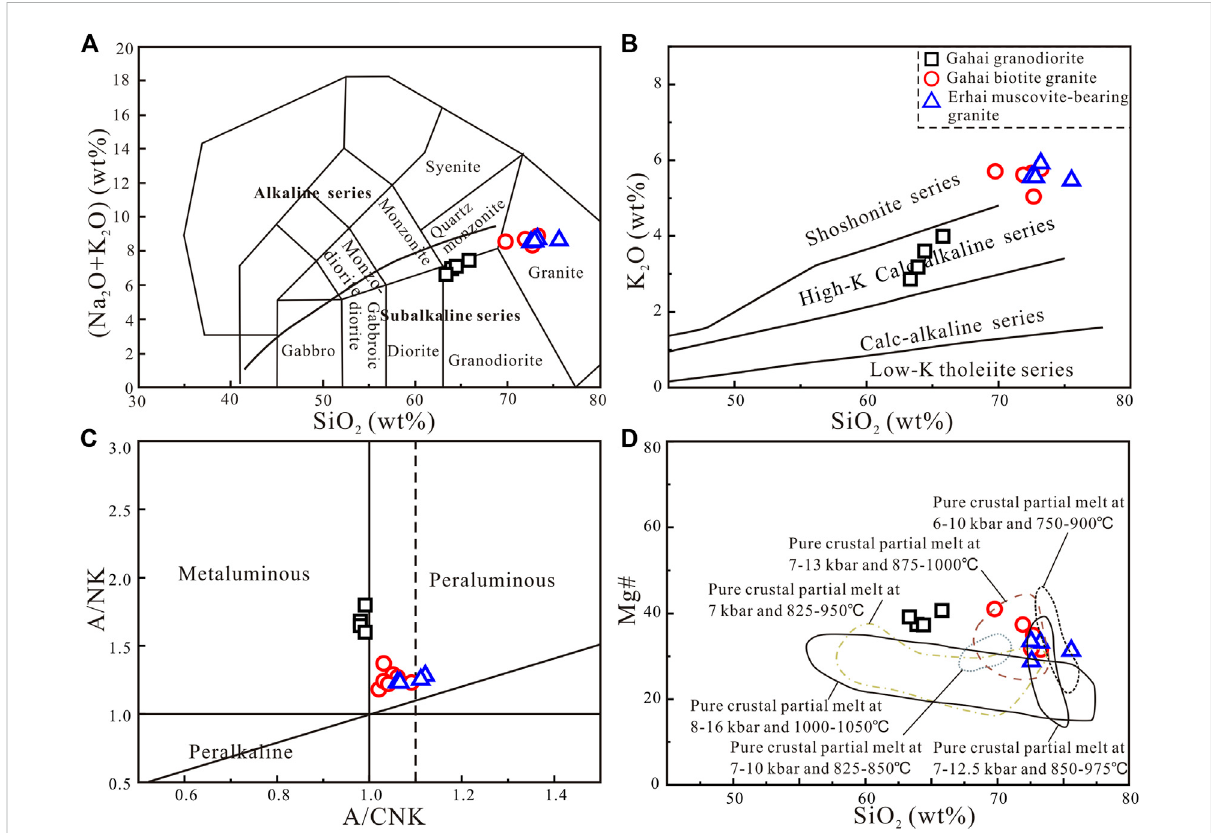
FIGURE 5 Geochemicalclassi fi cationofrepresentativesamplesfromtheGahaiandErhaiplutons (A) Totalalkalivs.silicadiagram(Middlemost,1994);with the thick solid line from (Irvine and Baragar, 1971); (B) K 2 O vs. SiO 2 diagram (Peccerillo and Taylor, 1976); (C) A/NK vs. A/CNK diagram (Chappell and White, 1974; Maniar and Piccoli, 1989); (D) Mg# vs. SiO 2 diagram (Jiang and Zhu, 2017).